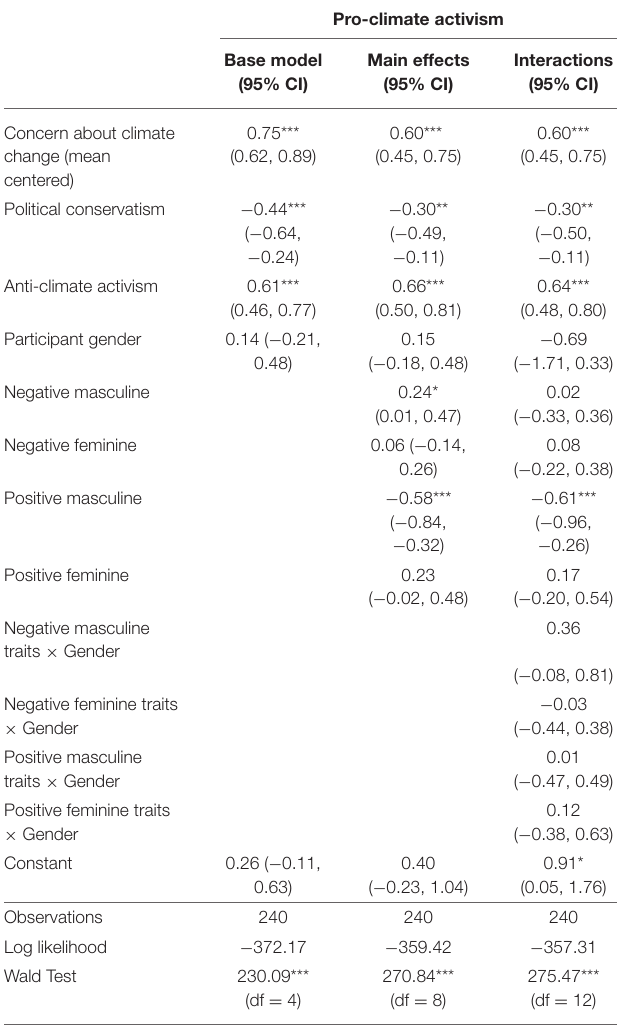
TABLE 6 | Impressions of the climate dismissive as predictors of pro-climate activism (Study